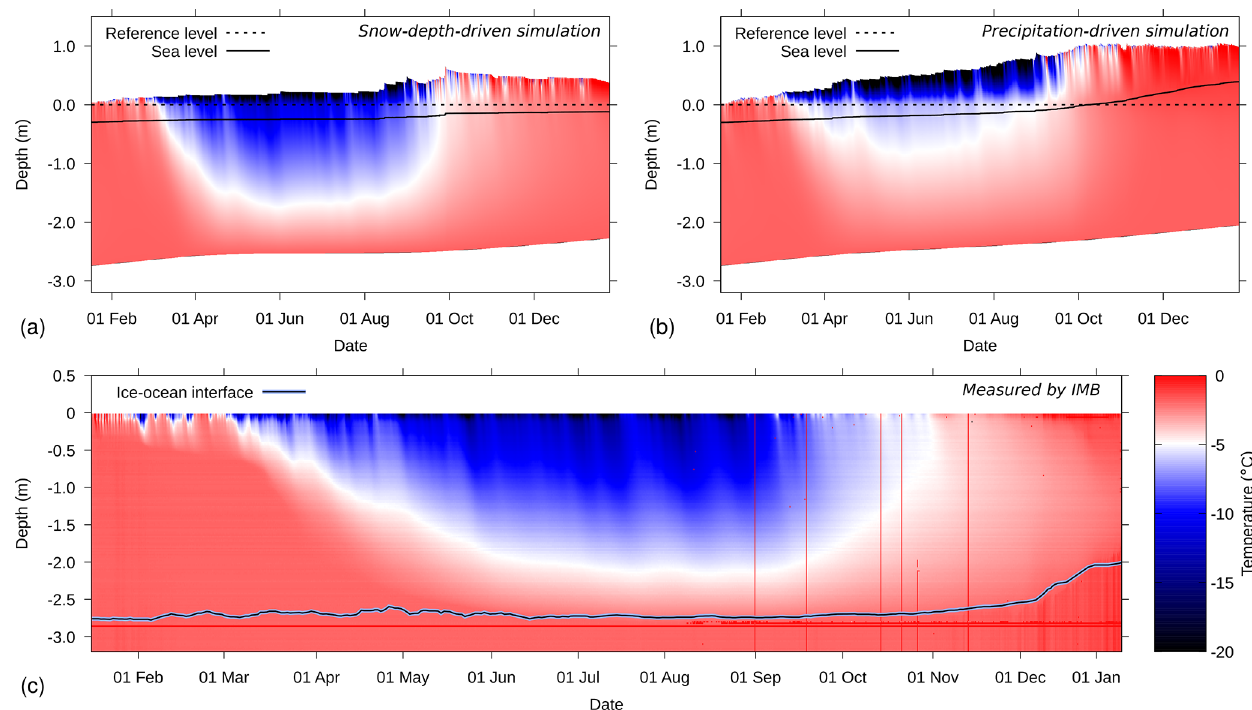
Figure 5. Snow and ice temperatures for snow buoy 2016S31/IMB 2016T41, for (a) simulations driven by in situ measured snow depth, (b) simulations driven by ERA5 precipitation, and (c) measured temperatures by the IMB. The depth on the y axis is defined relative to the snow–ice interface, as determined upon installation (dashed line). In (a) and (b) , the solid line denotes the sea level as determined by the simulations. In (c) , the blue/black line denotes the ocean–ice interface, as determined from the IMB